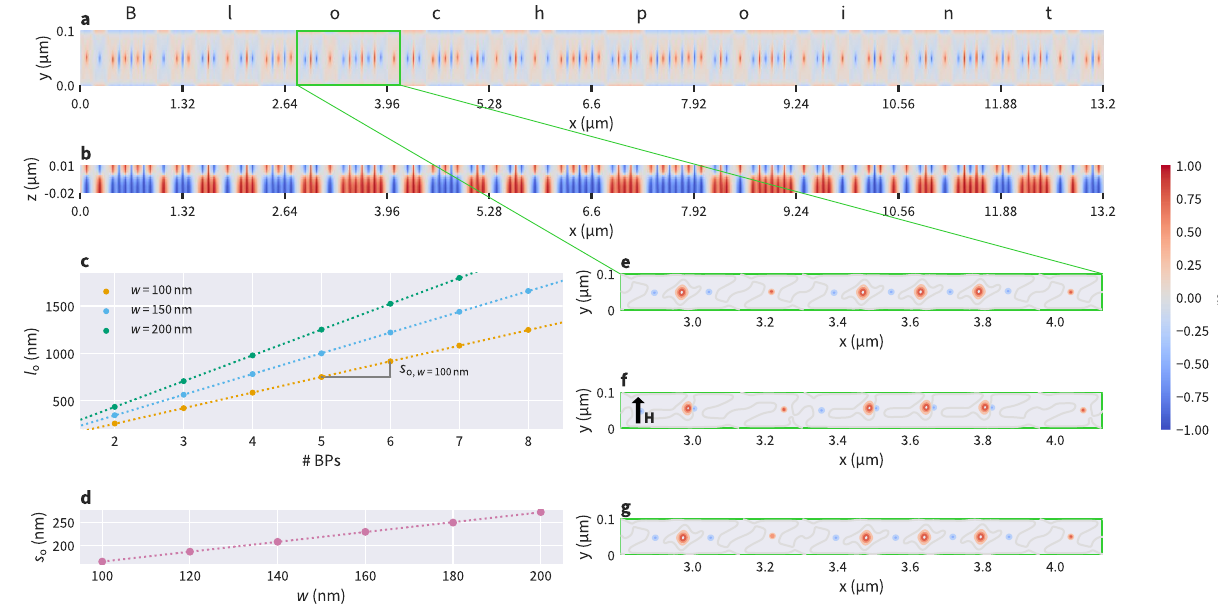
Figure 5. ( a , b ) ASCII encoding of the string Blochpoint using 80 Bloch points. Cross sections show ( a ) the xy plane at z = 1 nm and ( b ) the xz plane at y = 50nm . The strip length is chosen according to the predicted value for a nanostrip with width w = 100 nm . Labels on the x axis mark blocks of eight Bloch points, i.e. individual bytes. Note that the aspect ratio is not correct in order to improve visibility. ( c ) Optimal lengths l o for two to eight Bloch points. The fit is used to predict lengths for more than eight Bloch points. ( d ) Optimal Bloch point distance s o as a function of strip width w . (e – g) show an enlarged part of the nanostrip (correct aspect ratio) as highlighted in ( a ) to demonstrate the stability of the configuration: ( e ) initial configuration after energy minimisation; ( f ) an external magnetic field H = 0.25T /µ 0 is applied in the + y direction for 0.5ns ; ( g ) after removing the external field the system evolves freely and converges back to the initial state (snapshot after 5 ns ). ( e – g ) show contour lines of the m z component to improve visibility of the disturbance introduced by the external magnetic field. Bloch points are located at the small red and blue dots, the larger red circles show the additional